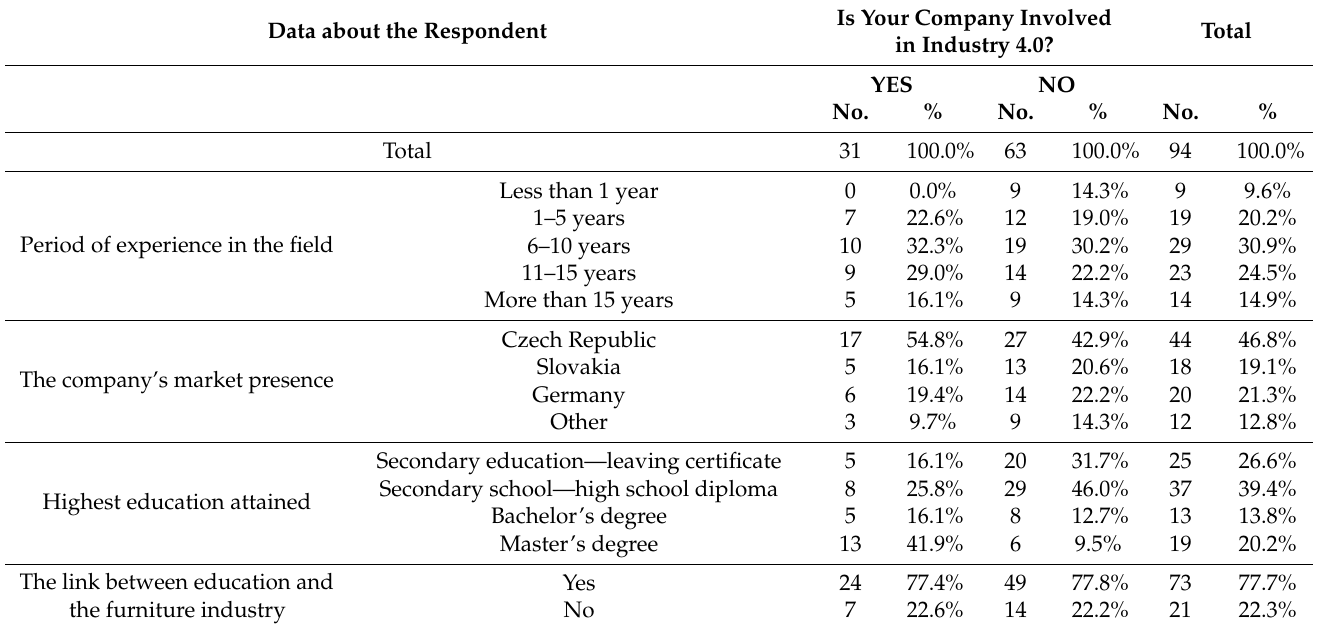
Table 2. Selected basic characteristics of the respondents.